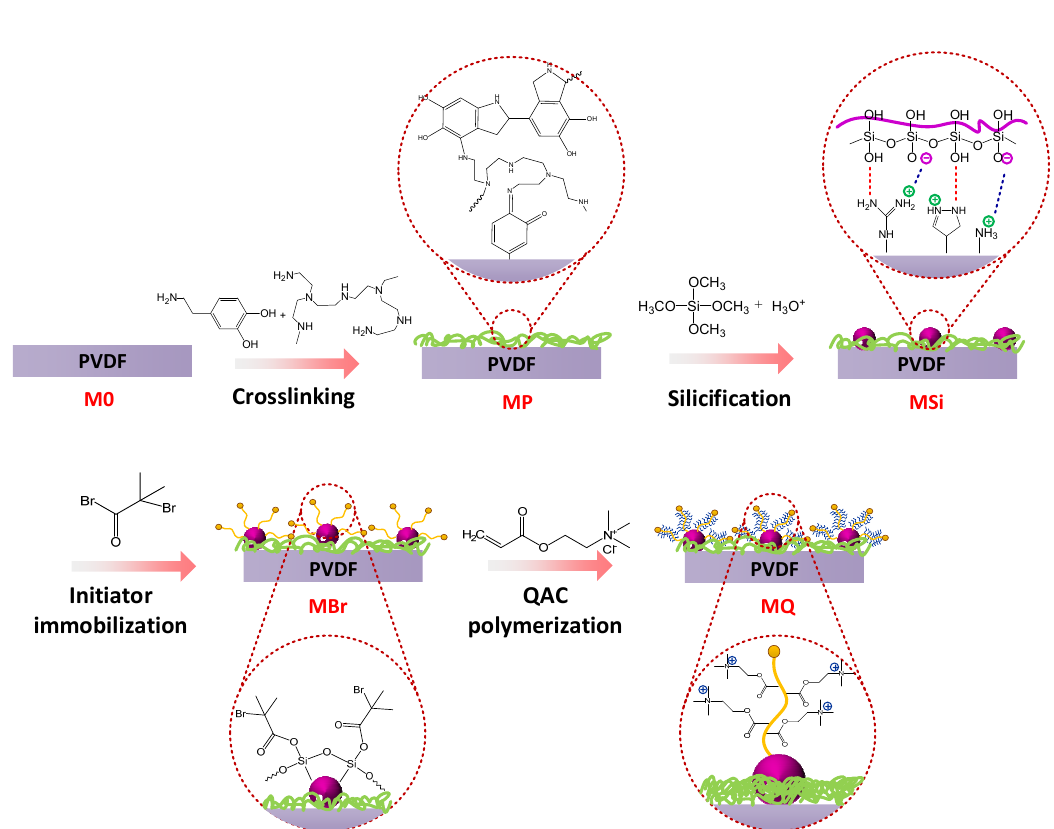
Figure 1. Schematic of modification procedures using ATRP and silica nanoparticles as interlayer for grafting QAC onto membrane surfaces for mitigating biofouling.